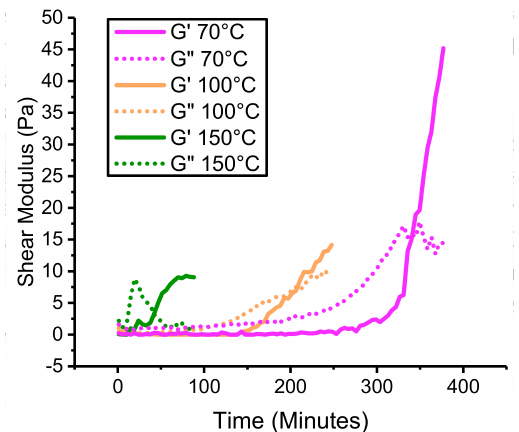
Figure 1. The 65—5 liquid (formulation described in Table 1) is heated to three di ff erent temperatures (70, 100, and 150 ◦ C) at 3.4 MPa, simulating three di ff erent wellbore environments. The data clearly show a decrease in gel time with increasing temperature and the thermal tolerance of the gel transitions out to 150 ◦ C. Reprinted (adapted) with permission from [9]. Copyright (2018) American Chemical